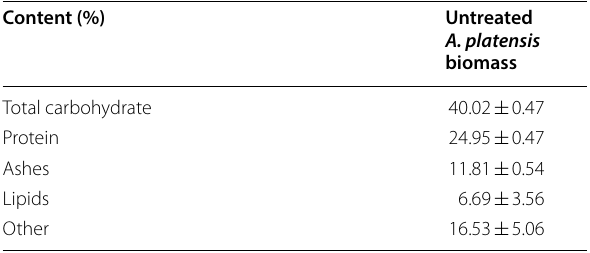
Table 1 Characterization of A. platensis biomass produced in raceway ponds